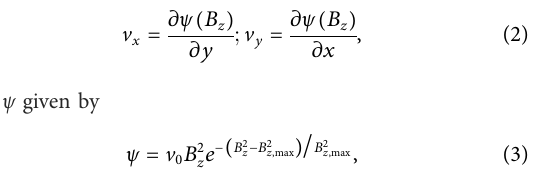
B z , max )ineachdiagram, 2